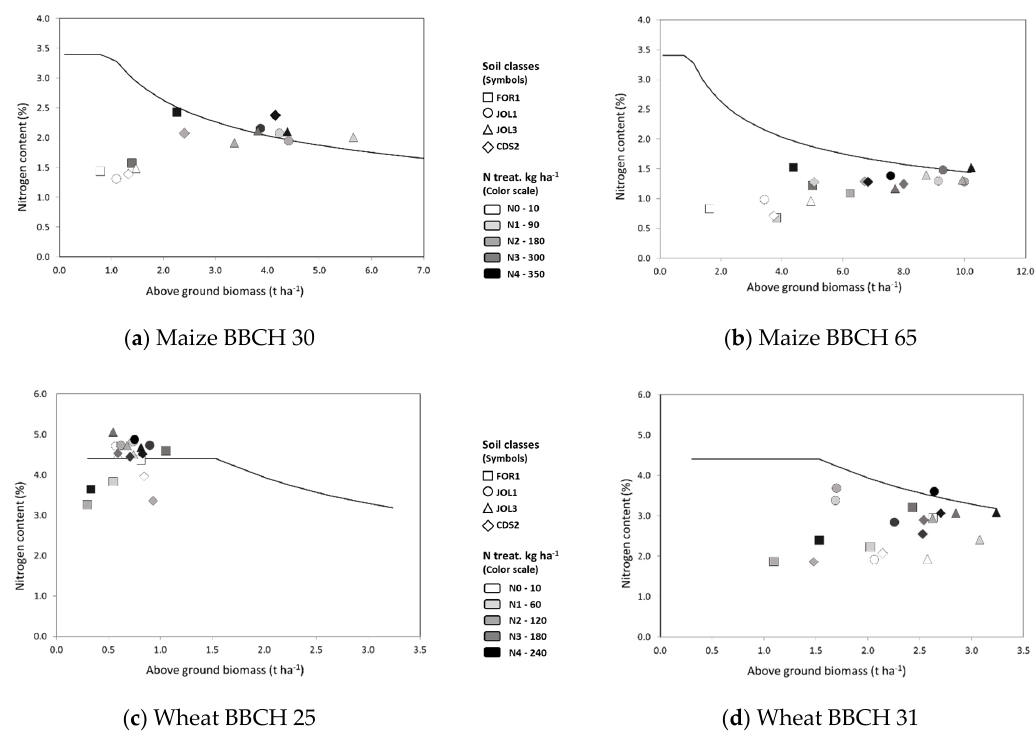
Figure 4. Relationships between biomass and N content for different soil classes at different N rates compared to the crop specific critical N dilution curve for maize and wheat.